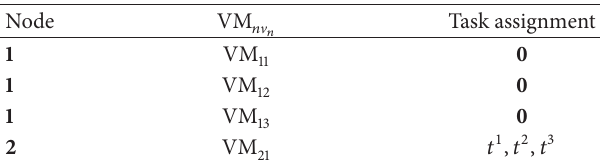
Table 3: Without communications. High optimal Erlang . Solver assignment.